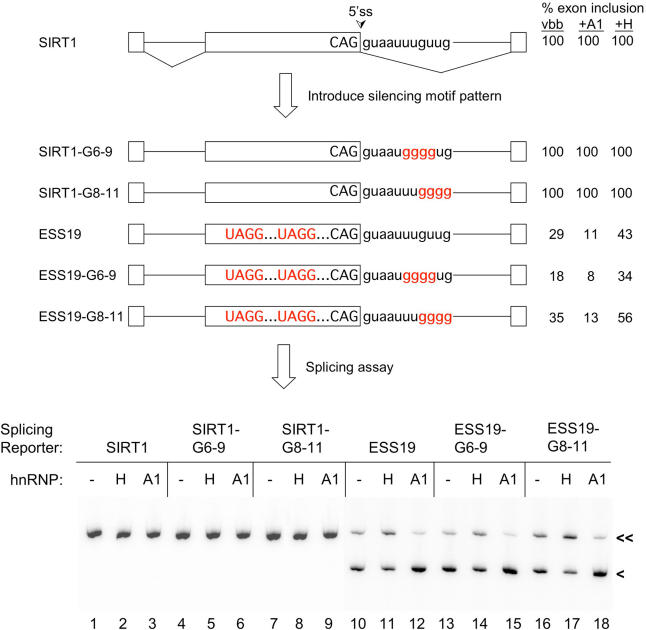
Analysis of UAGG and
GGGG Motif Pattern in a Heterologous Context and Effects of hnRNP A1 and H Co-Expression
At the top is a schematic of the heterologous splicing reporter SIRT1 (pZW8) that contains exon 6 of the human SIRT1 gene and flanking intron sequences as described previously [17]. The intron/exon lengths (in nucleotides) are as follows: exon 1, 308; intron 1, 340; exon 2, 95; intron 2, 287; and exon 3, 436. The silencing motif pattern was introduced sequentially into the middle exon and adjacent 5′ splice site region as highlighted in red.
GGGG mutations were introduced by site-directed mutagenesis at positions 6–9 or 8–11 of the second intron. Exonic UAGG motifs were introduced into the middle exon by replacing a HindIII-KpnI restriction fragment AAGCTT
TCGAATTCGGTACC, with AAGCTT
GT
TAGGTA
TAGG
TACC (restriction sites are underscored) as described [17]. The percent exon inclusion values (average of three repeats) were determined from co-expression assays with vector backbone (vbb) or with a 1:4 ratio of hnRNP A1 or H expression plasmid (same as experiment of Figure 3). Below are shown splicing assays following expression in C2C12 cells in the absence and presence of hnRNP A1 (“A1” lanes) or hnRNP H (“H” lanes) protein expression vector. Control reactions contained vector backbone plasmid (“−” lanes). Exon-included (double arrowheads) and exon-skipped (single arrowheads) products are indicated.